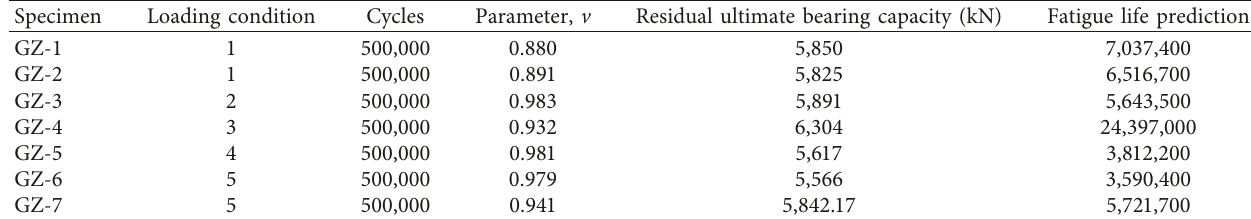
Table 3: Fatigue life prediction.